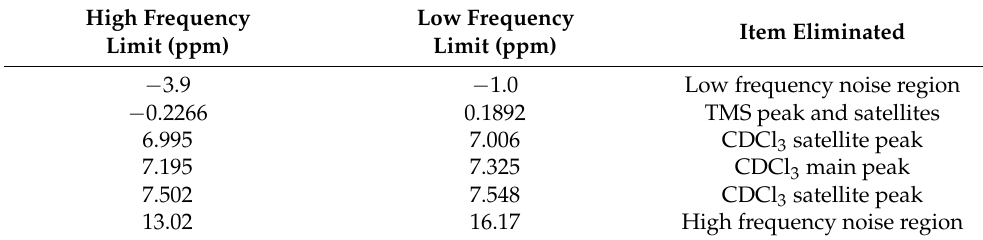
Table 3. List of blinded regions used in the PCA analysis.